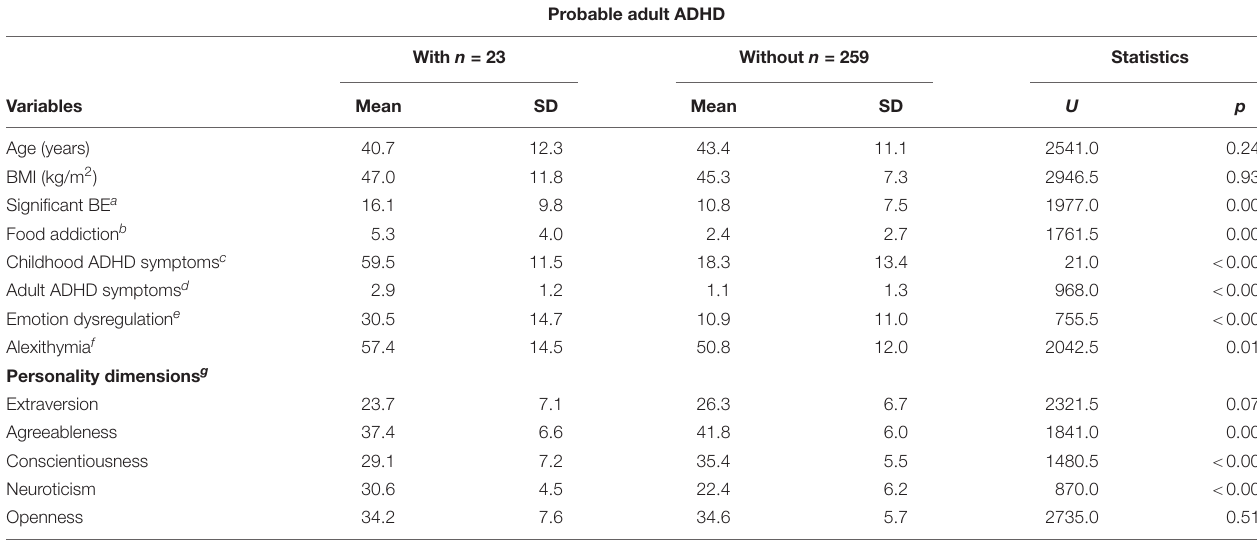
TABLE 2 | Comparison between persons with vs. without probable adult ADHD. Probable adult ADHD With n = 23 Without n =